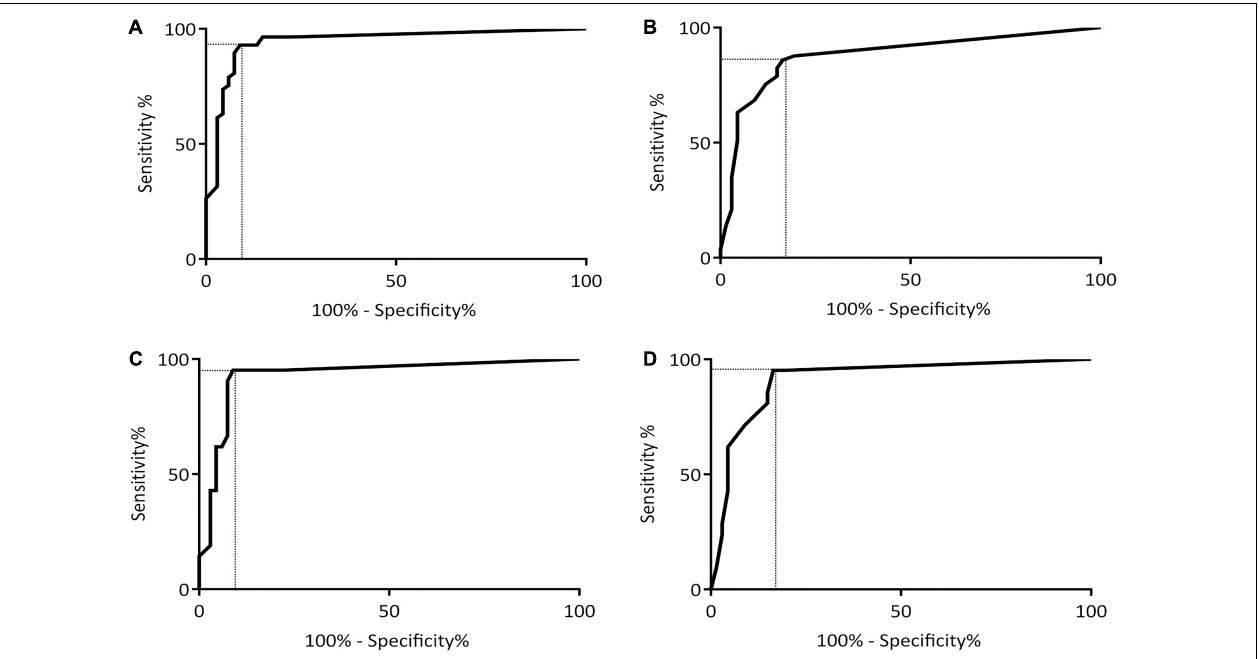
FIGURE 2 | ROC curves for the DUDIT and the DUDIT-C with sensitivity plotted against 100%-specificity. Dotted lines mark levels of sensitivity and 100%-specificity that are in line with optimal cut-off score based on Youden’s Index J. (A) ROC curve for the DUDIT in the complete sample. (B) ROC curve for the DUDIT in the sample of mild and moderate cases. (C) ROC curve for the DUDIT-C in the complete sample. (D) ROC curve for the DUDIT-C in the sample of mild and moderate